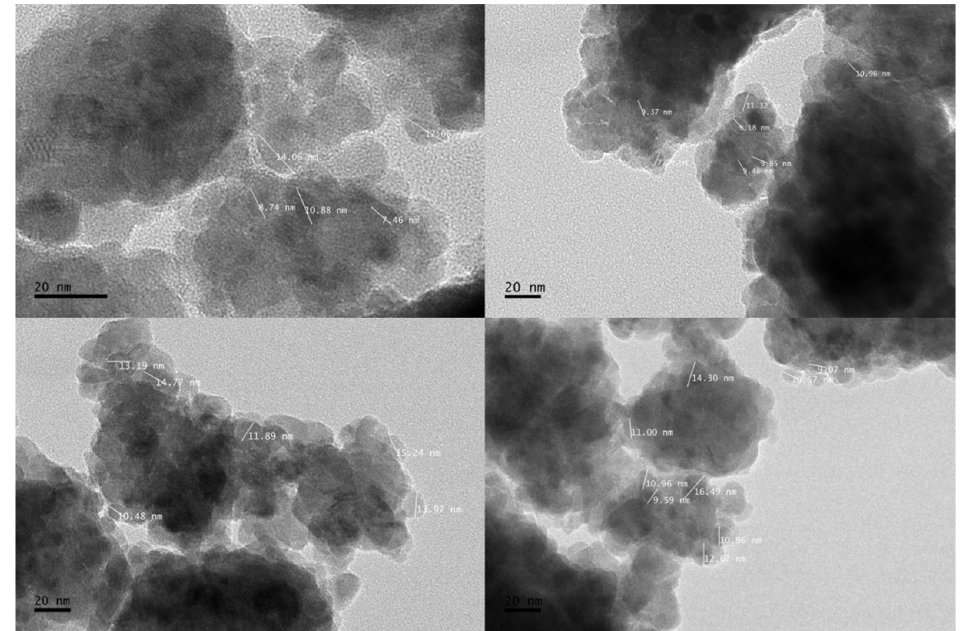
Figure 6. HRTEM images of rFe 2 O 3 nanoparticles.